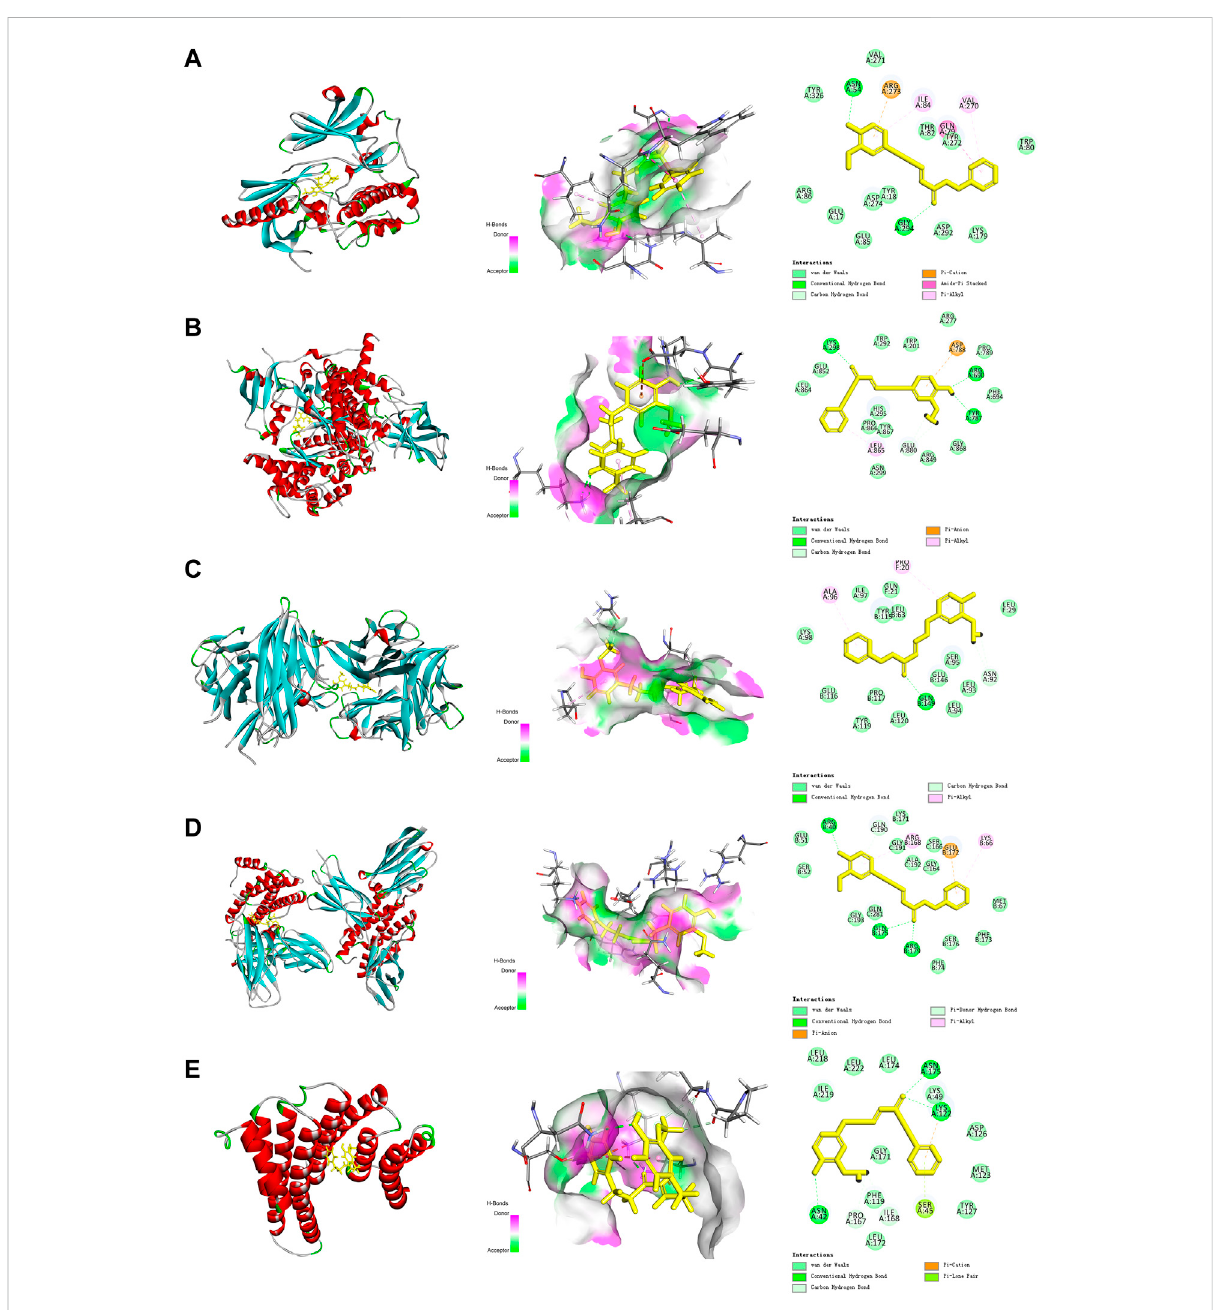
FIGURE 3 Molecular docking diagram of each target with DPHB. (A) AKT1; (B) PIK3CA; (C) TNF; (D) IL-6; and (E)